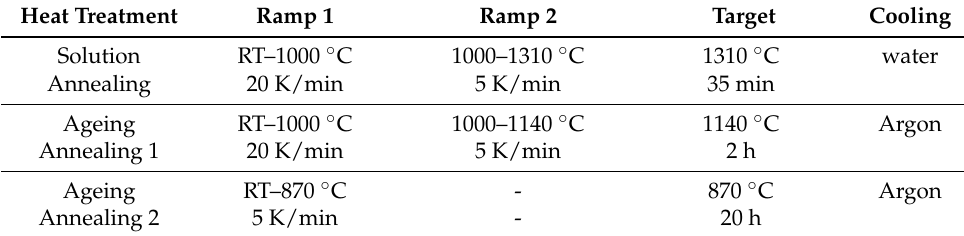
Table 2. The heat treatment procedure for the single crystals (SX) samples.